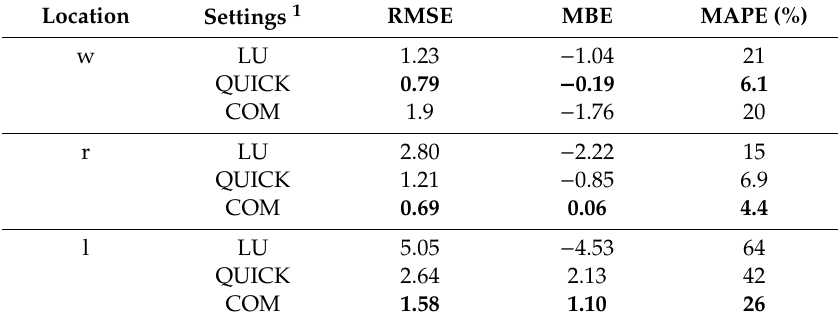
Table 5. Model root mean square error (RMSE), mean bias error (MBE), and mean absolute percent error (MAPE) for wind speeds at windward (w), ridgetop (r), and leeward (l) sensor locations at Askervein Hill. Positive MBE indicates model over-prediction. Bold font indicates the lowest error at each location. Location Settings 1 RMSE MBE MAPE